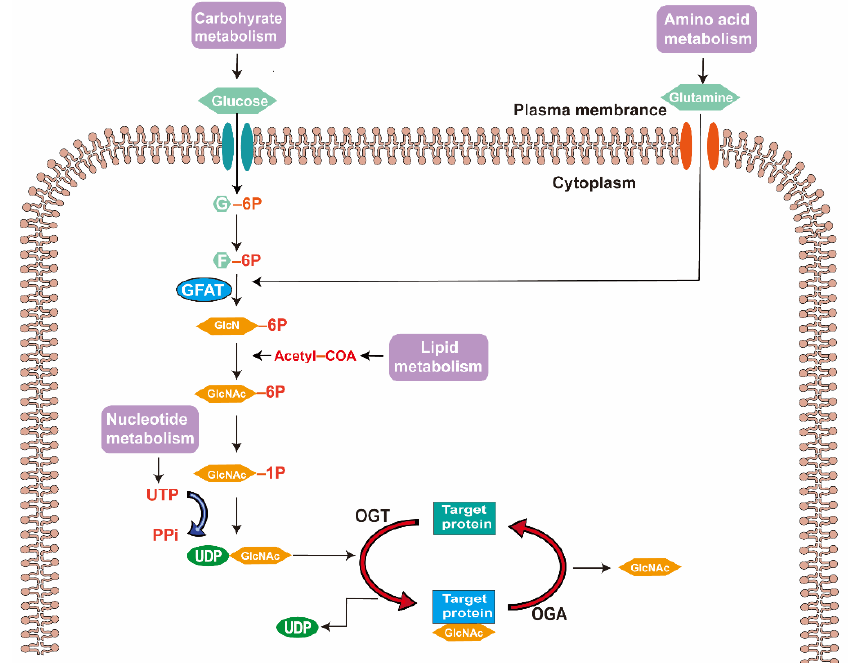
Figure 1. Hexosamine biosynthesis pathway and protein O -GlcNAcylation process. Glutamine: fructose-6-phosphate amidotransferase (GFAT) is the rate-limiting enzyme in the hexosamine biosynthesis pathway (HBP) and is responsible for converting F-6-P into GlcN-6P. The end product of HBP, UDP-GlcNAc, acts as a substrate for O -GlcNAcylation. Abbreviations: G-6P, glucose to glucose-6-phosphate; F-6P, fructose-6-phosphate; GFAT, glutamine: fructose-6-phosphate amidotransferase; GlcN-6P, glucosamine-6-phosphate; GlcNAc-6P, N-acetylglucosamine-6-phosphate; GlcNAc-1P, N-acetylglucosamine-1-phosphate; UTP, uridine triphosphate; PPi, pyrophosphoric acid; UDP-GlcNAc, UDP-N-acetylglucosamine; UDP, uridine diphosphate; OGT, β -N-acetylglucosaminyltransferase; OGA, O -GlcNAc hydrolase.